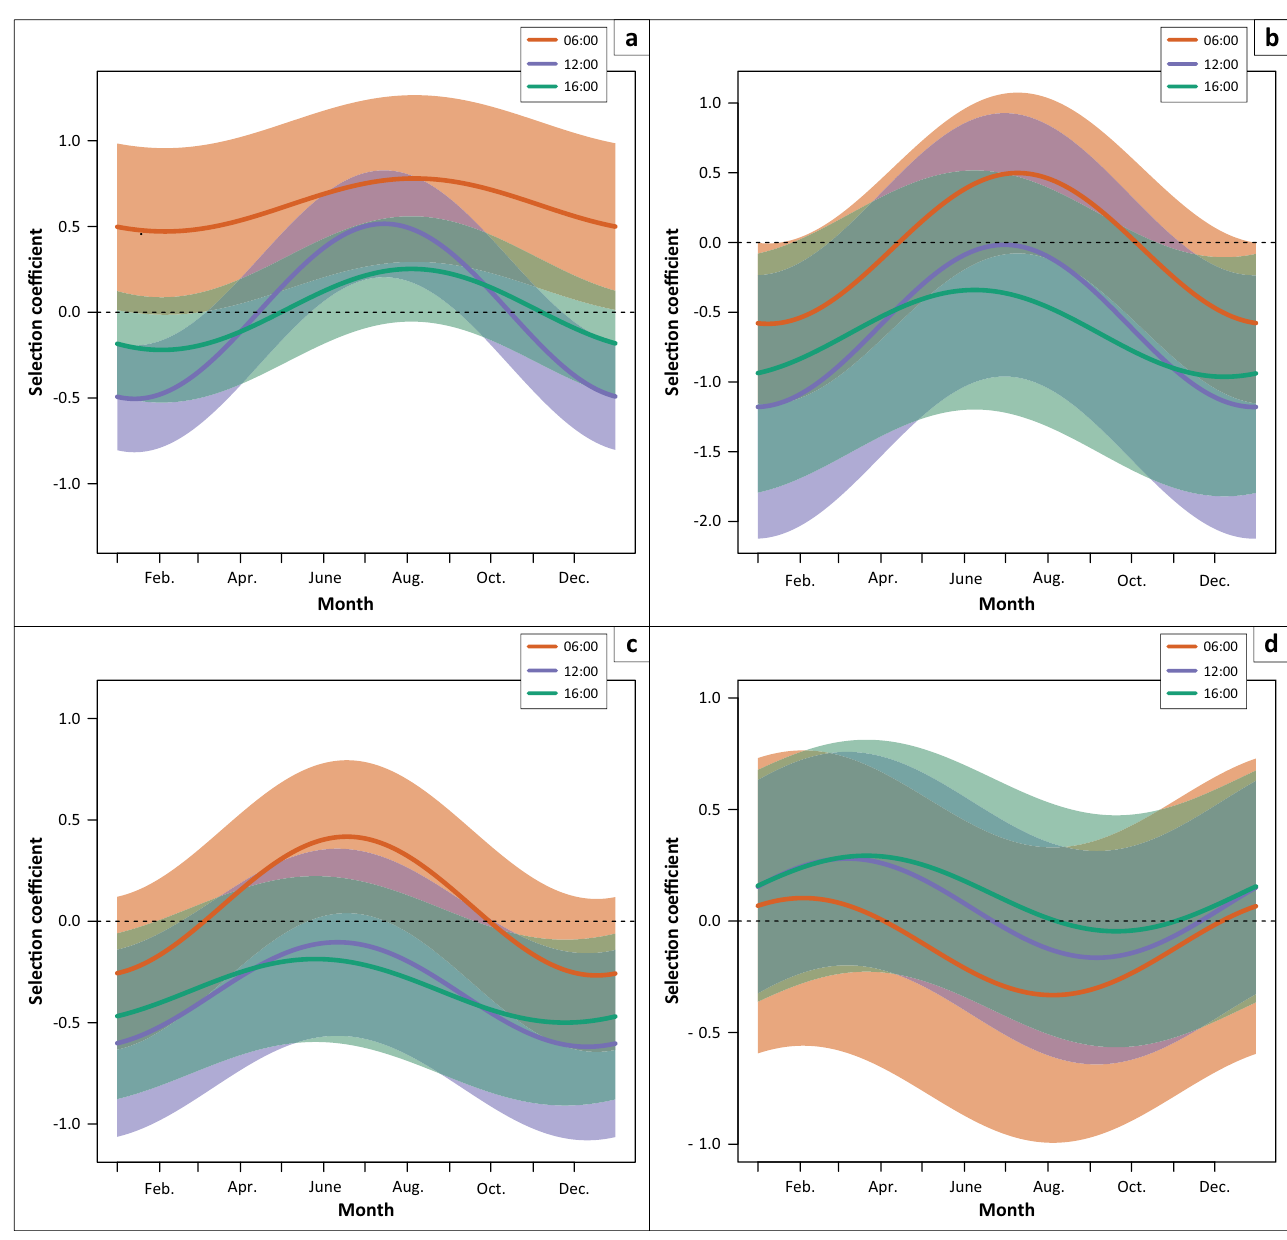
The horizontal dashed line indicates no selection. Periods of the year where the confidence interval intersects this line have a lack of support for selection or avoidance of that resource. Note that the y -axes vary across panels. FIGURE 2: Plots of annual coefficient estimates (lines) and their 95 % confidence intervals (shaded regions) derived from step selection functions of daily elephant movements recorded at 06:00 (red), 12:00 (blue) and 16:00 (green) for (a) the Normalised Difference Vegetation Index, (b) distance to artificial water, (c) slope and (d) terrain